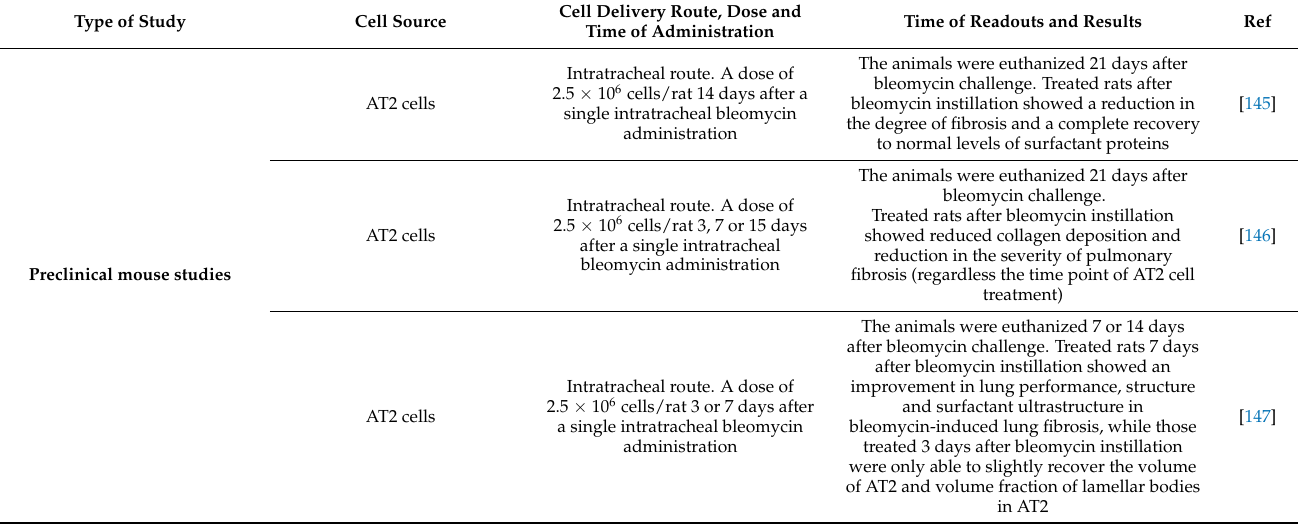
Table 2. Cell therapy in preclinical mouse studies and clinical human